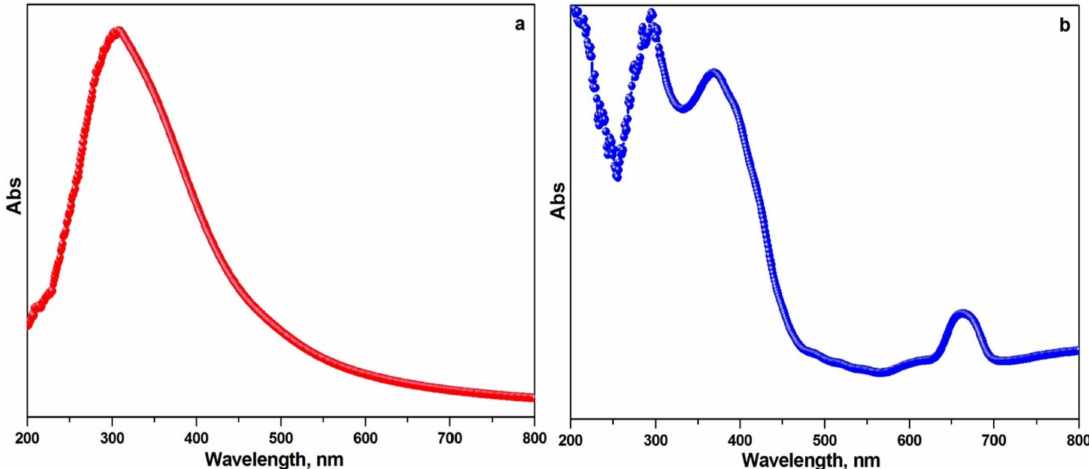
Figure 4. UV-visible spectrum of: ( a ) Pure C. tagal extract; ( b ) inhibited C. tagal .